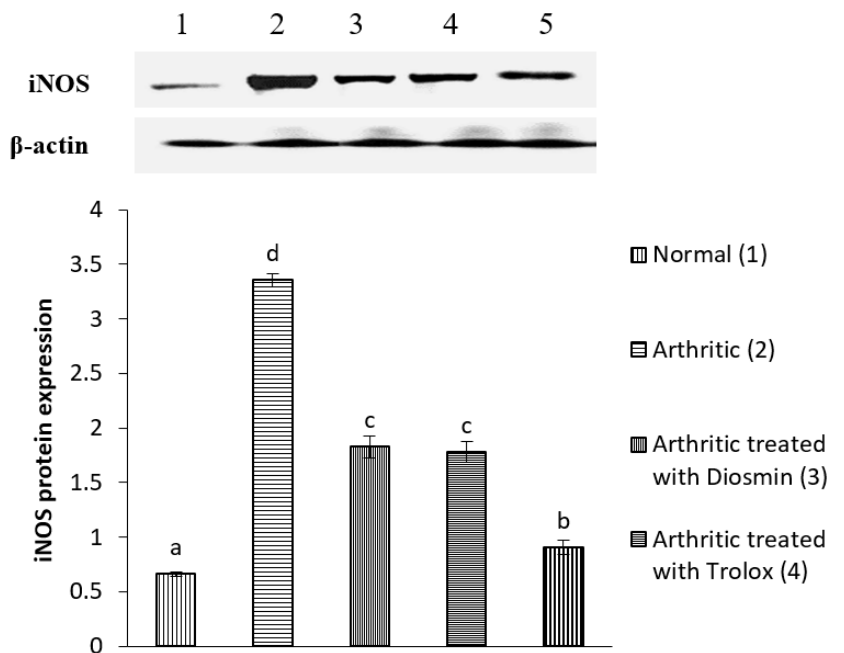
Antioxidants 2022 , 11 , x FOR PEER REVIEW Figure 6. Effect of diosmin, trolox and their combination on iNOS protein expression level in CFA-induced arthritic rats. Means that have the same symbol (s) are not significantly different ( n = 3).